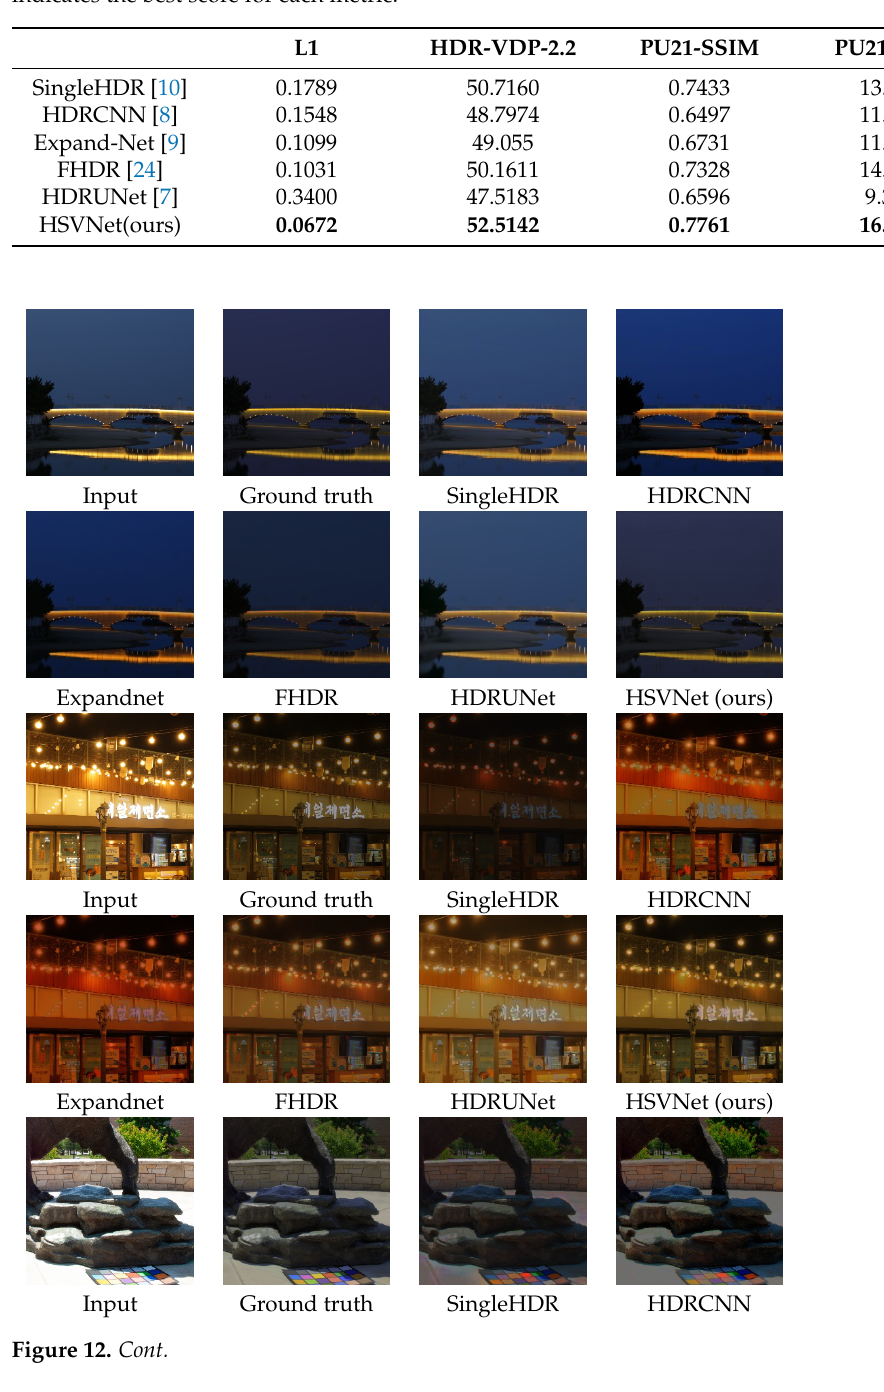
Table 5. The test results of our HSVNet and existing methods in four metrics. The value in bold indicates the best score for each metric.